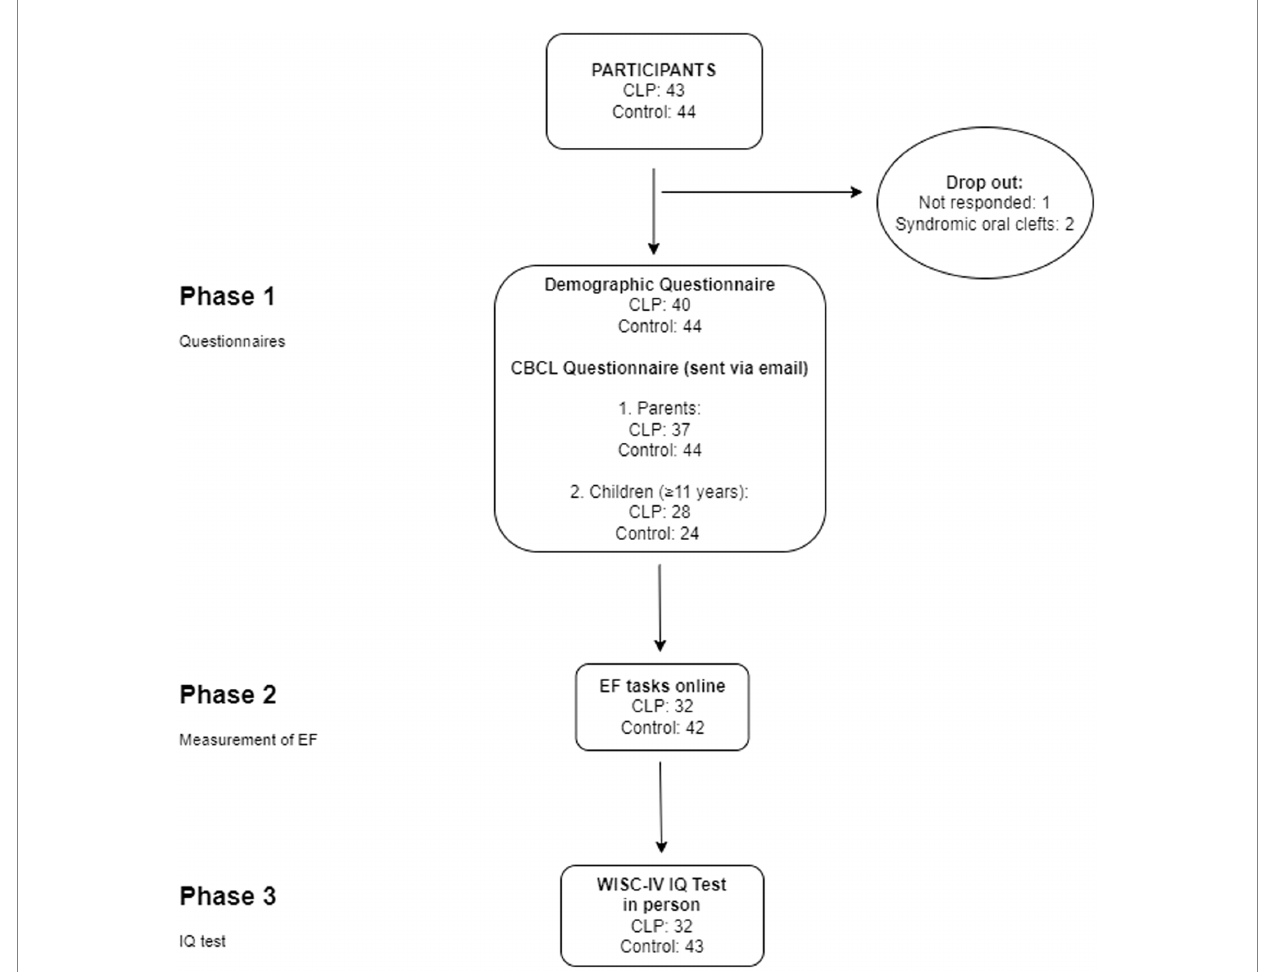
FIGURE 1 Study flow. The analyzes were divided into three phases. The number of the participants are provided for each phase (CLP, cleft lip and/or palate group; EF, executive function; IQ, intelligence quotient).